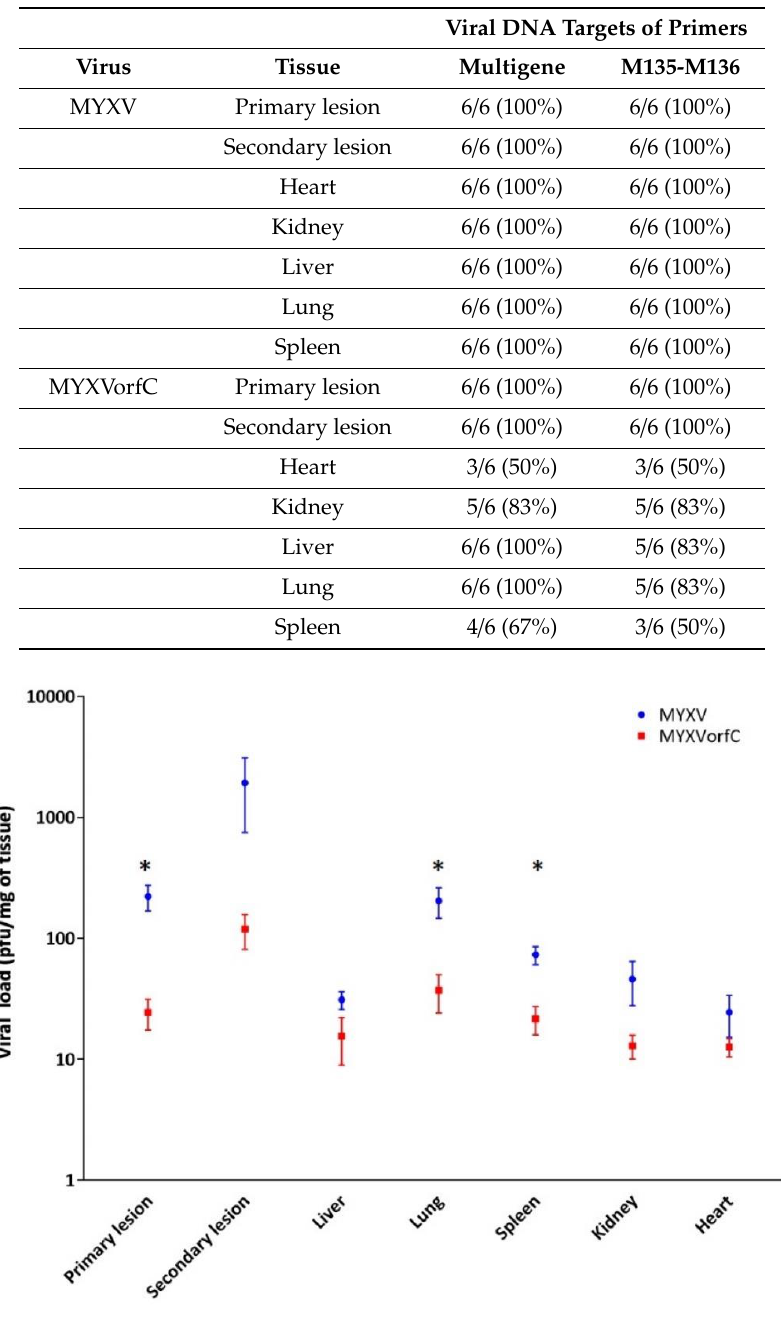
Table 1. Detection of MYXV or MYXVorfC by PCR in rabbit tissues collected at the time of euthanasia from rabbits inoculated with 50 pfu MYXV or MYXVorfC ( n = 6 per group).